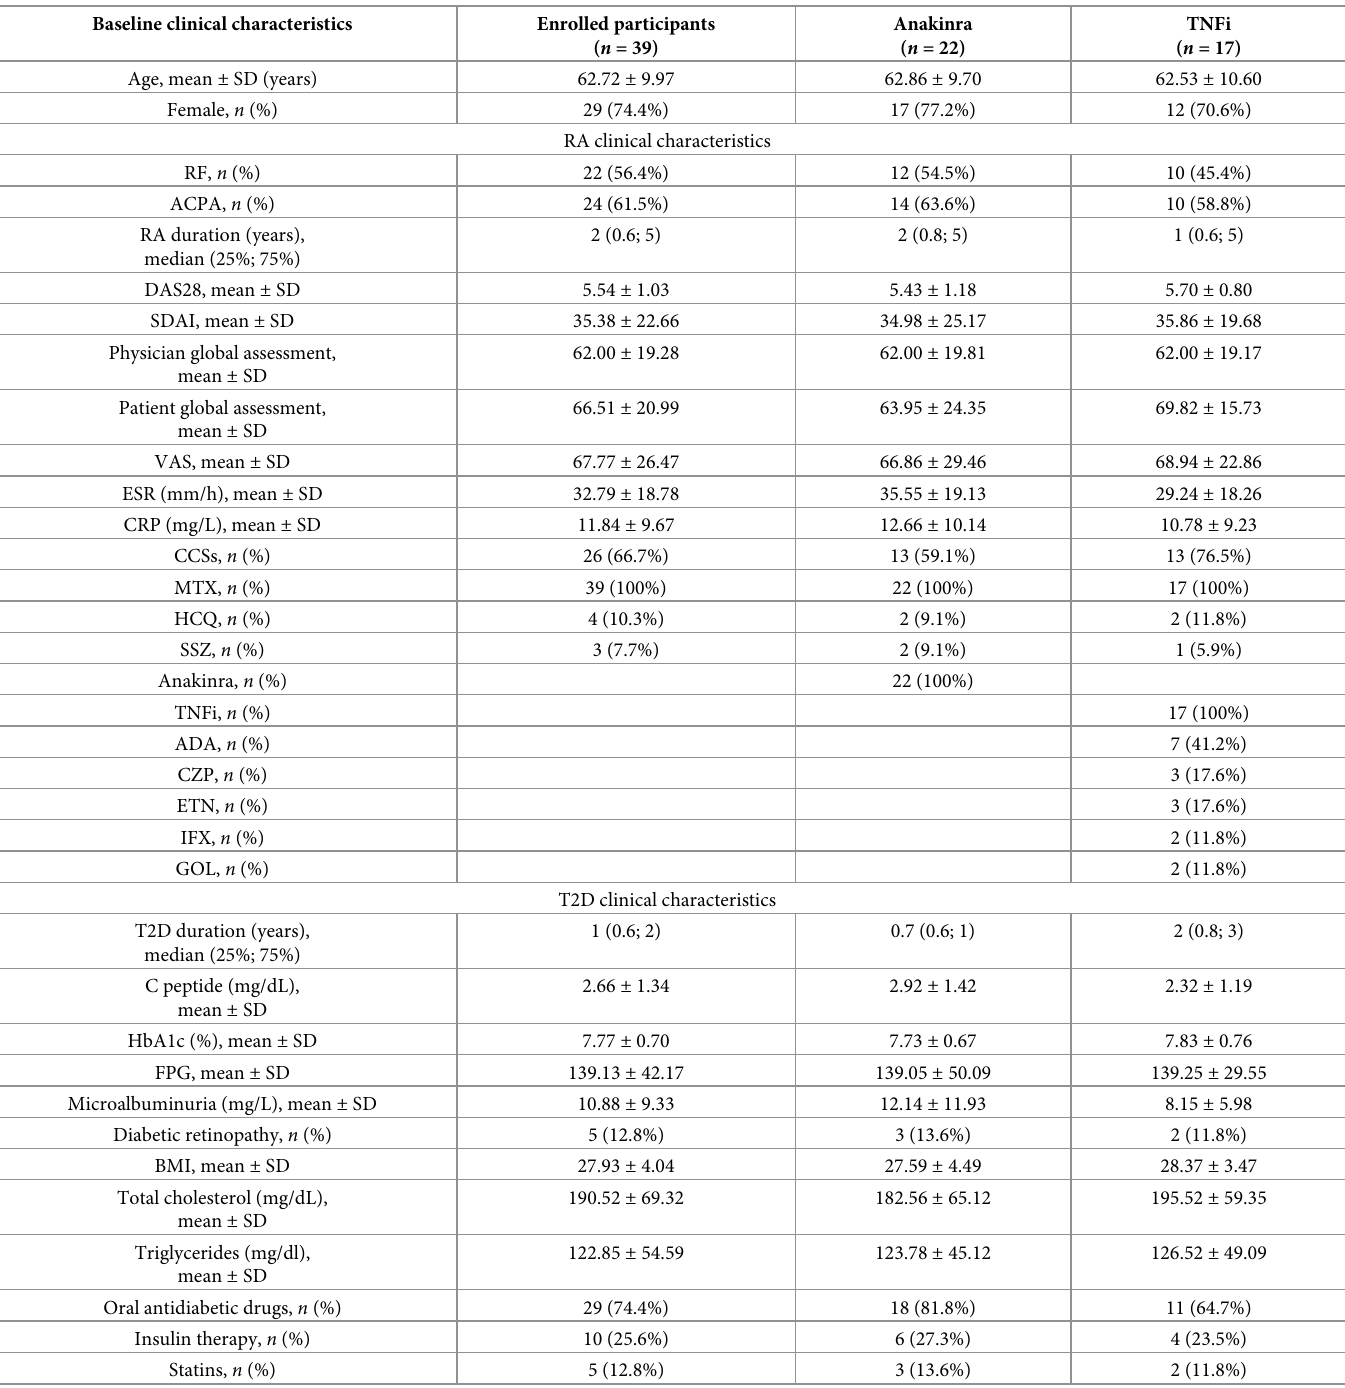
Table 1. Baseline clinical characteristics of the randomised